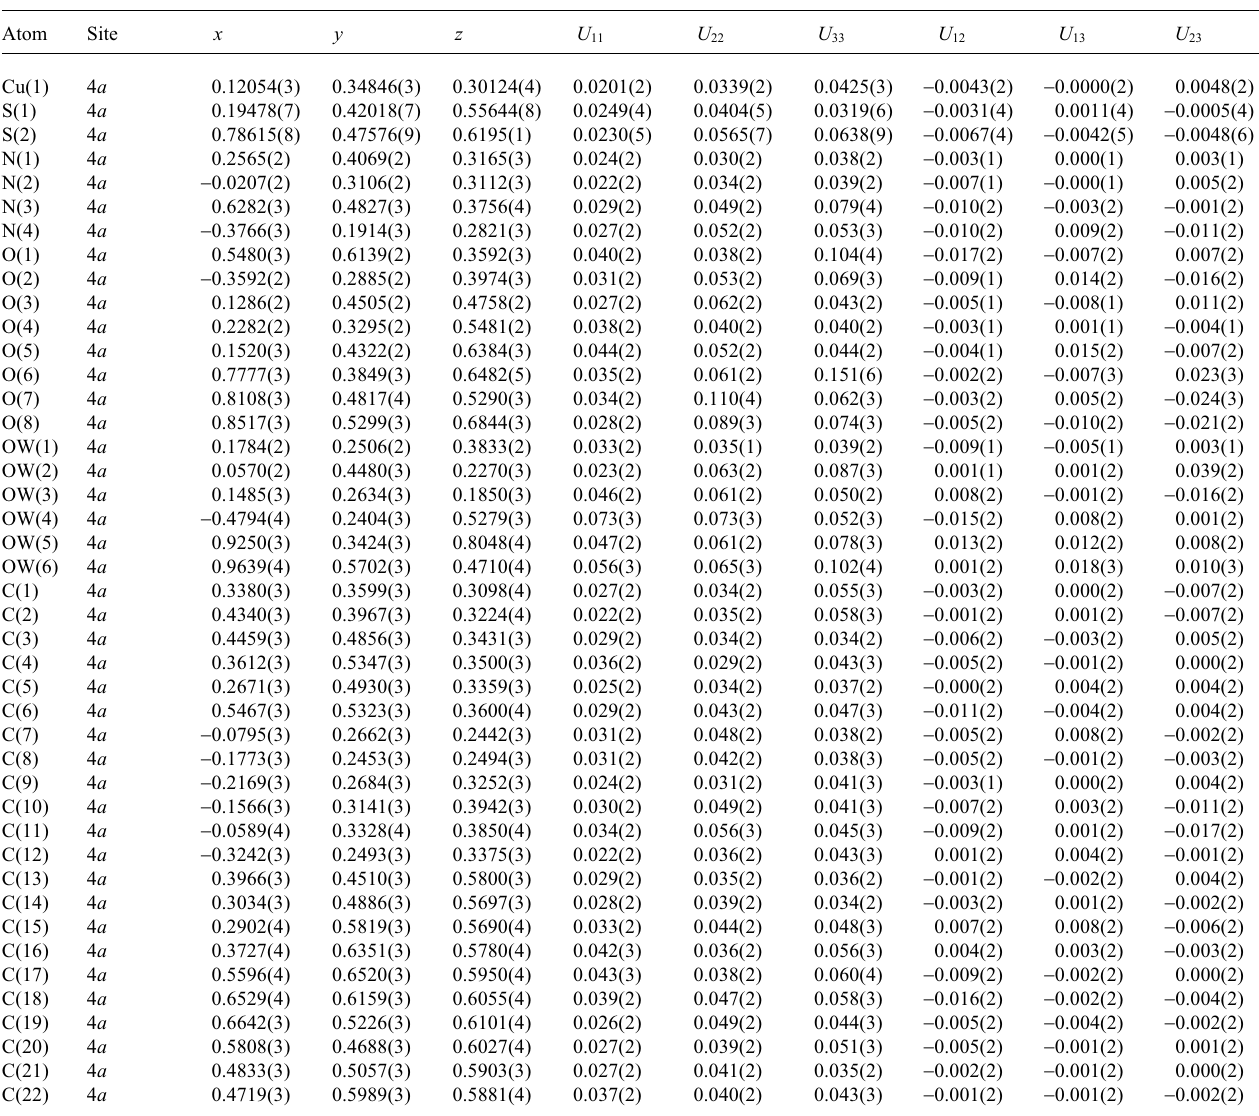
Table 3. Atomic coordinates and displacement parameters (in Å 2 )